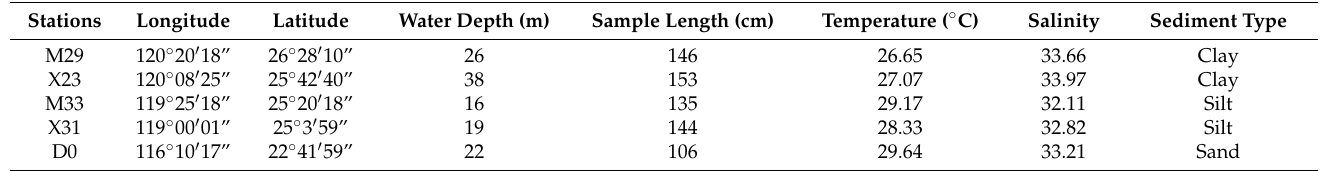
Table 1. Sampling locations and parameters measured in the field at the five